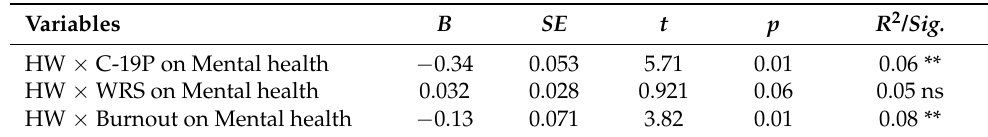
Table 6. Moderating effects of handwashing on the relationship between COVID-19 phobia, burnout, WRS, and mental health.